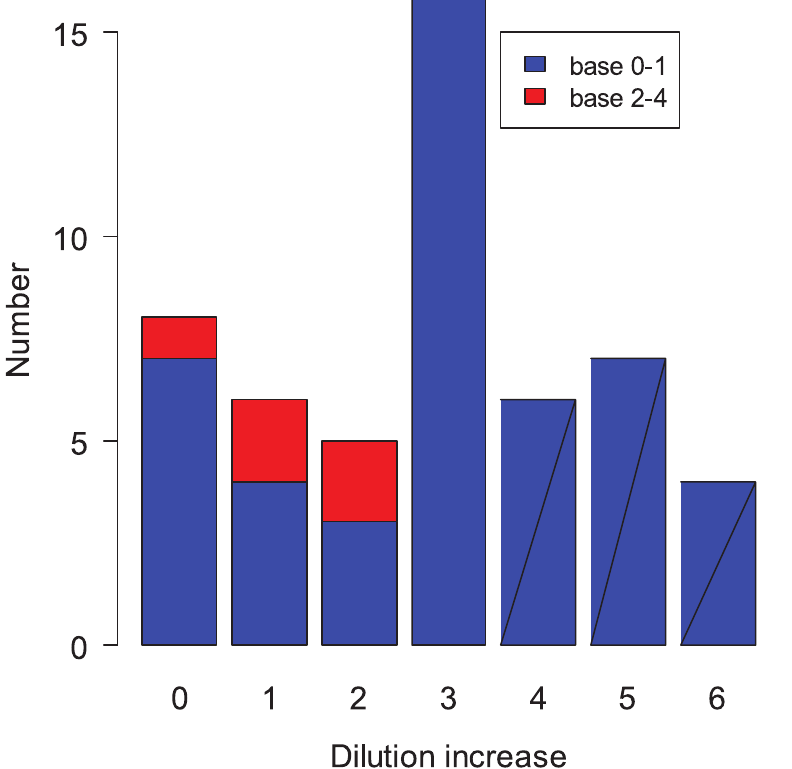
Figure 4. Distribution of observed increase in PCR positive cases as a function of baseline. Individuals with a low antibody titer baseline (0–1) are in blue; those with a higher baseline (2–4) are in